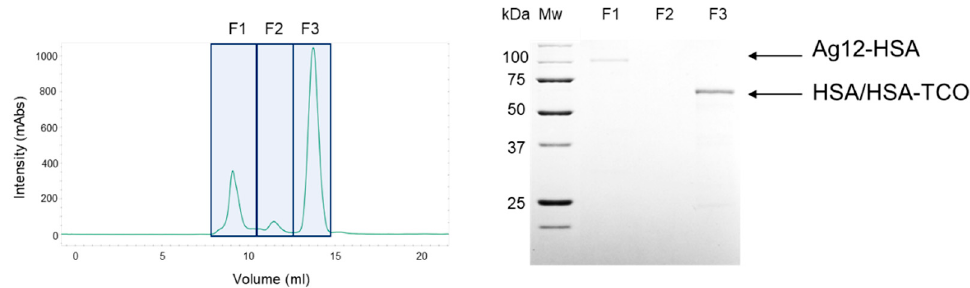
Figure 6. Purification of HSA-conjugated Ag12 variant (Ag12-HSA). Size-exclusion chromatography of Ag12-HSA conjugate mixture ( right ) and SDS-PAGE analysis of the eluted fractions (F1–F3) of Ag12-HSA ( left ). The protein gel was stained by Coomassie blue for the visualization of protein bands. Lanes: MW, molecular weight marker.